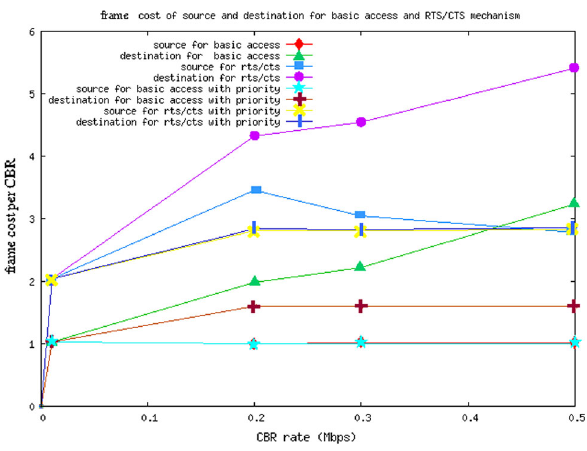
Fig. 6 Normalized control overhead in the 7-nodes chain